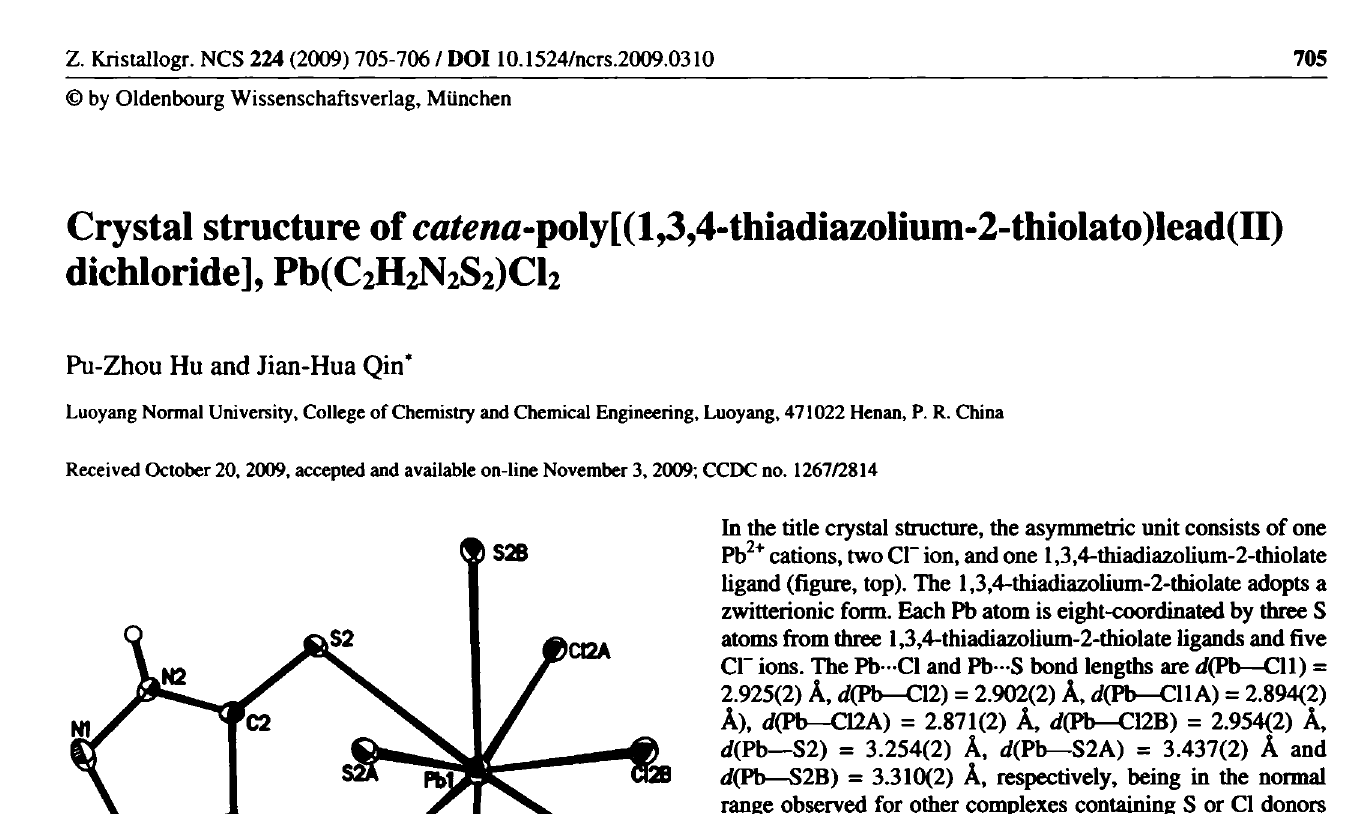
Table 1. Data collection and handling. Crystal: